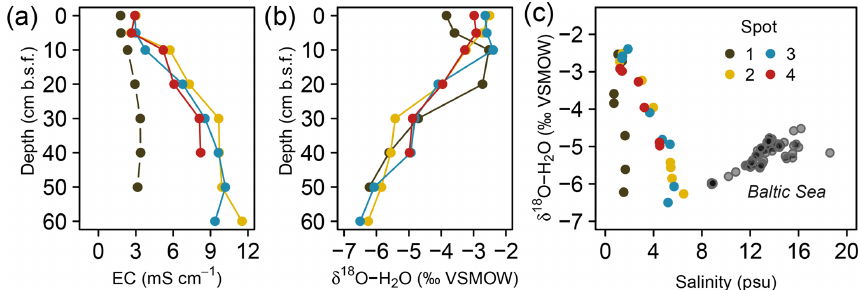
Figure 2. Depth distribution of electrical conductivity (EC, a ) and pore water O isotope composition (b) . Panel (c) depicts a scatter plot of pore water O isotope composition and salinity. Grey transparent dots in (c) represent a common positive δ 18 O–H 2 O vs. salinity relationship derived from a sampling campaign of Baltic Sea surface water (Westphal, unpublished).